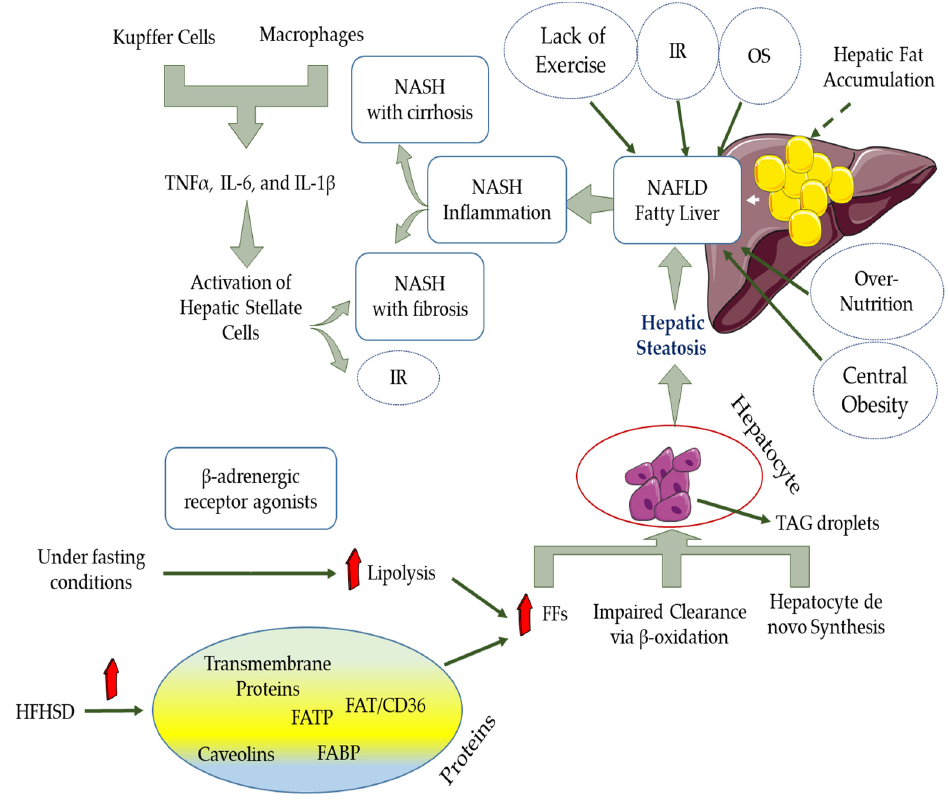
Figure 3. Various factors such as central obesity, insulin resistance (IR), type 2 diabetes (T2D), overnutrition, lack of exer- cise, and other metabolic syndrome parameters predispose multiple diseases such as NAFLD. Macrophages and Kupffer cells can stimulate pro-inflammatory mechanisms and then satellite cell activity at the liver surface by secreting inflam- matory cytokines such as IL-6, TNF- α , and IL- β . In such inflammatory environments, conditions are provided for increas- ing the deterioration of IR and the development of liver fibrosis. It should be noted that the increased flow of FAs to the liver through the bloodstream, the synthesis of de novo hepatocytes, and impaired clearance through β -oxidation lead to the accumulation of TAG droplets in hepatocytes. Various proteins such as FATP, transmembrane proteins, FABP, cave- olins, and FAT/CD36 can accelerate the absorption of FA by increasing the proliferation of FFA in blood vessels. It is noteworthy that these proteins’ expression can improve by an HFHSD. On the other hand, in fasting conditions, FFAs are mainly produced during the lipolysis process by beta-adrenergic receptor agonists [126–133].